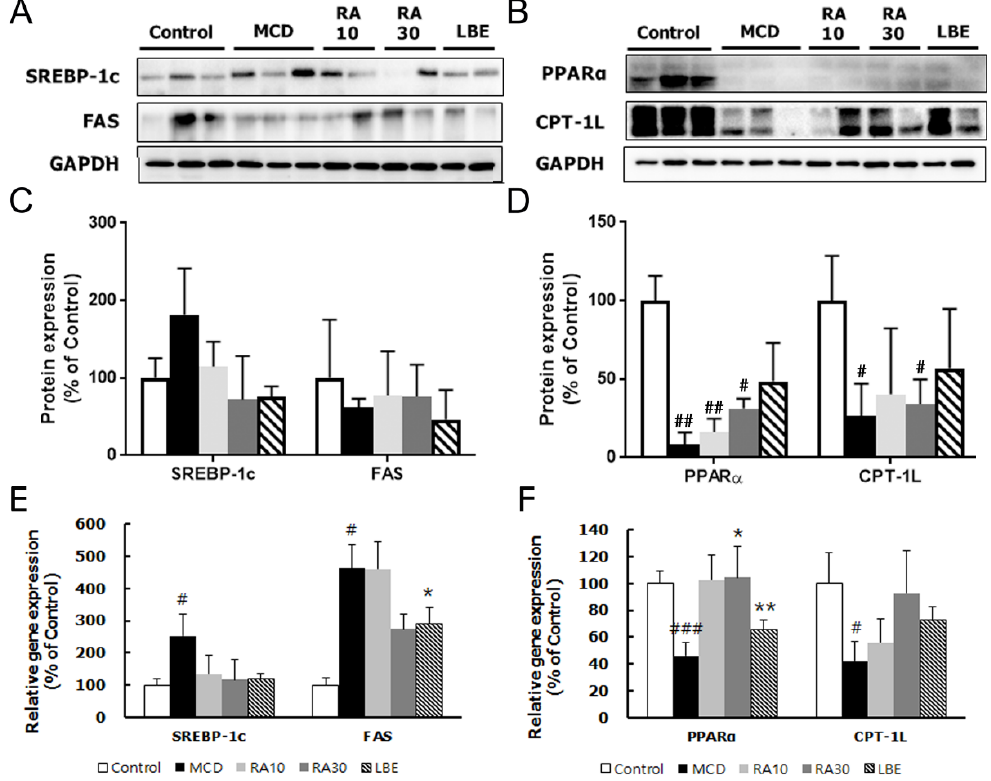
Figure 7. Effects of LBE and RA on the expression of genes and proteins involved in fatty acid regulation in MCD diet-fed db / db mice. Protein levels of ( A ) SREBP-1c and FAS, and ( B ) PPAR α and CPT-1L. The densitometric analysis of Western blot of ( C ) SREBP-1c and FAS, and ( D ) PPAR α and CPT-1L, normalized to those of glyceraldehyde 3-phosphate dehydrogenase (GAPDH) mRNA levels of the genes encoding ( E ) SREBP-1c and FAS , and ( F ) PPAR α and CPT-1L . β -Actin was used as an internal control for qPCR analysis. Results are expressed as the mean ± SD (% control). # p < 0.05, ## p < 0.01, and ### p < 0.001 compared with the control group; * p < 0.05 and ** p < 0.01 compared with the MCD diet-fed group ( n = 5–6 per group).